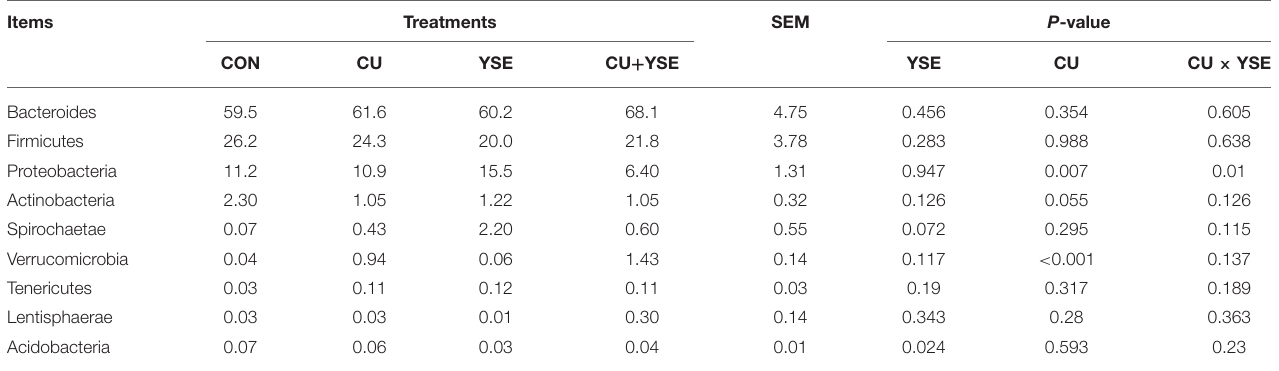
TABLE 8 | Effects of dietary YSE and oral CU on the relative abundance of caecum microflora at phylum level.